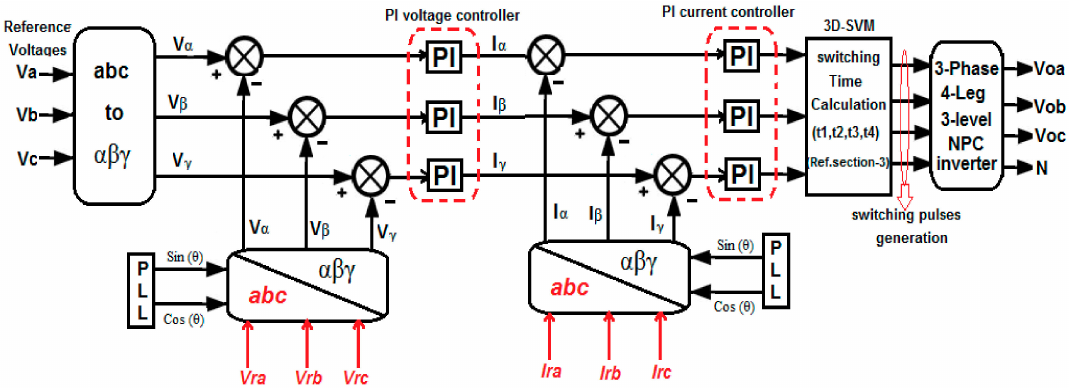
Figure 4. Block diagram of the current and voltage control loop for proposed